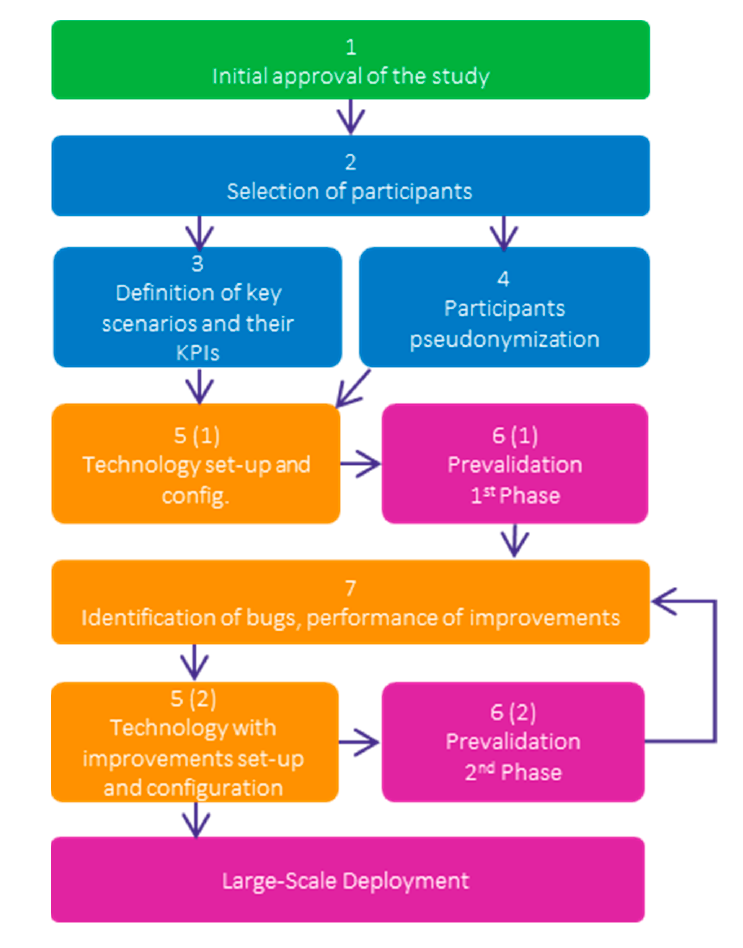
Figure 8. Prevalidation protocol followed by the six Pharaon pilots. Table 4. Scenarios defined for each technology of the Pharaon Murcia Table 3. Inclusion and exclusion criteria defined for users involved in the Pharaon Murcia pilot.